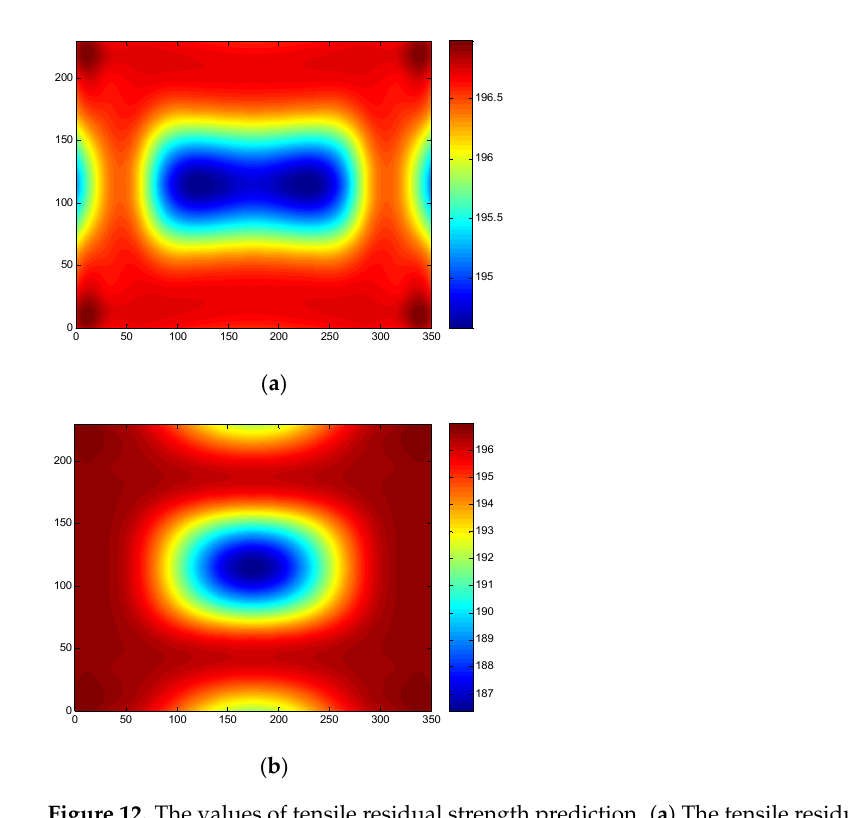
Figure 12. The values of tensile residual strength prediction. ( a ) The tensile residual in the direction of the length of the panel; ( b ) The tensile residual in the direction of the width of the panel. Table 4 indicates that the maximum error in the direction of length between the ex- perimental data and the simulation results is 8.92%, the minimum error in the direction of length is 6.39%, and the error of specimen 23 in the center of the panel along the width is 4.17%. It can been seen that the residual strength simulation results are conservative compared to experimental data. By comparing experimental data with simulation results, the simulation results are consistent with the experimental data. Table 4. Comparison between simulation and experimental results. Tensile Residual/MPa Series Num- ber